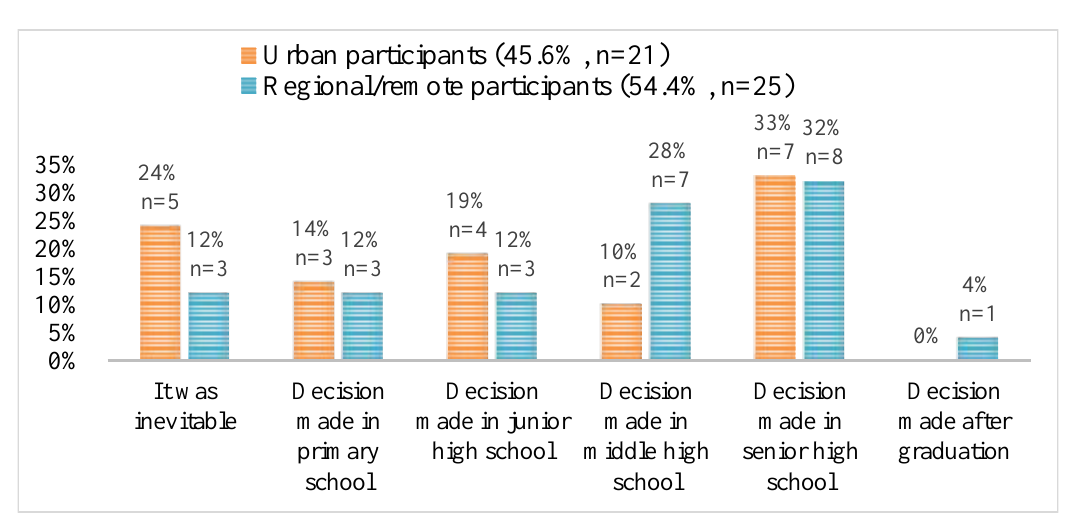
Figure 1. Comparing when LSES urban and LSES regional students decide to go to